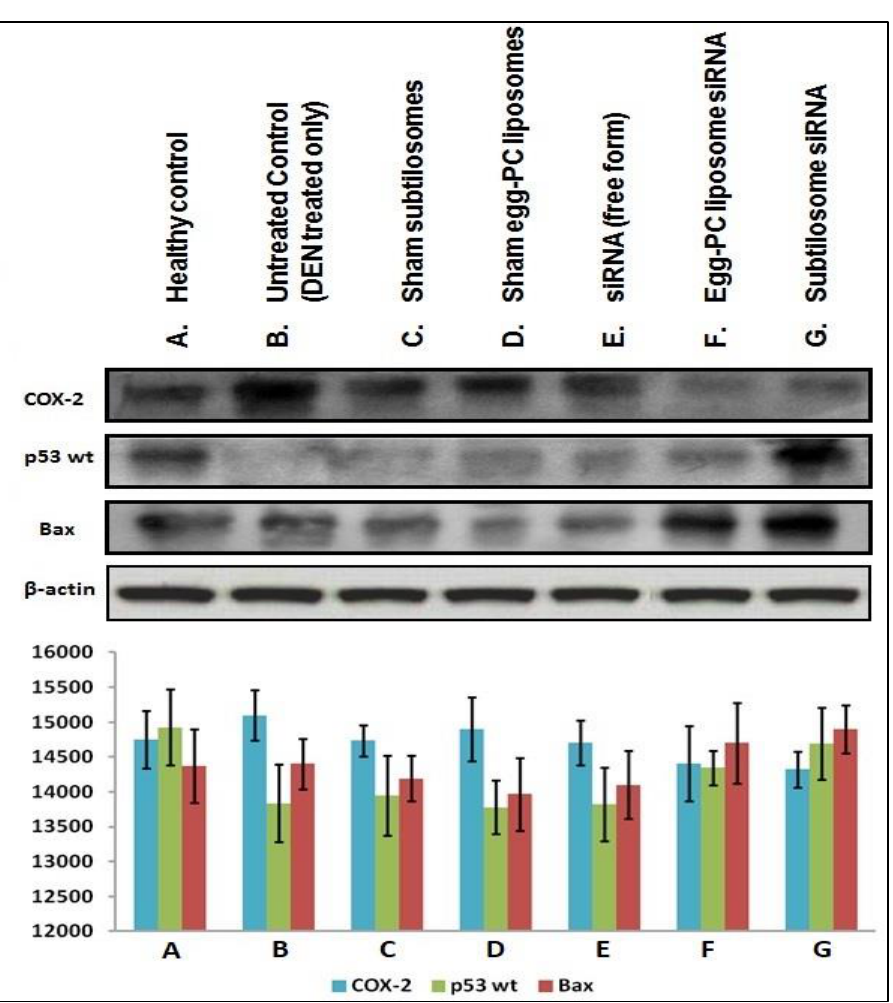
Figure 7. Expression profiles of COX-2 and various apoptotic molecules in the liver cells isolated from various si-RNA formulation-treated animal groups. Western-blot assay of COX-2, p53 WT, and Bax in a liver extract from mice treated with multiple COX-2-siRNA-bearing liposomal formu- lations.